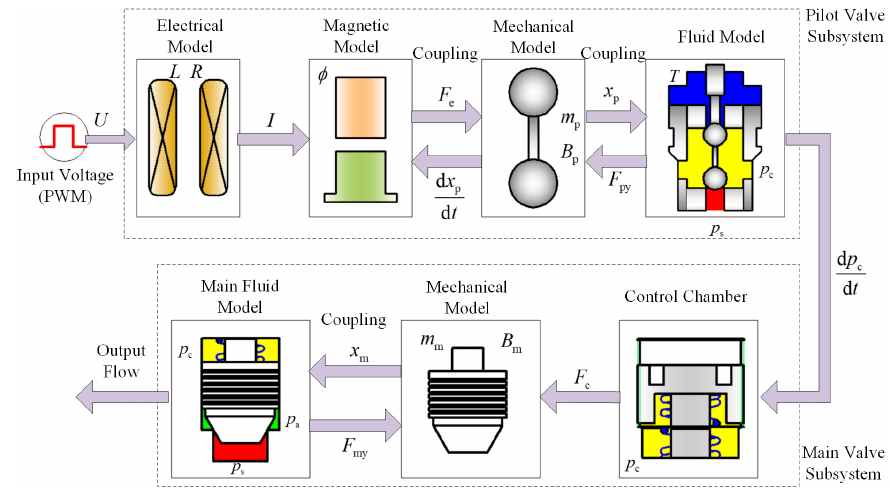
Figure 2. Schematic diagram of energy transfer and coupling motion of the AMOHSV.